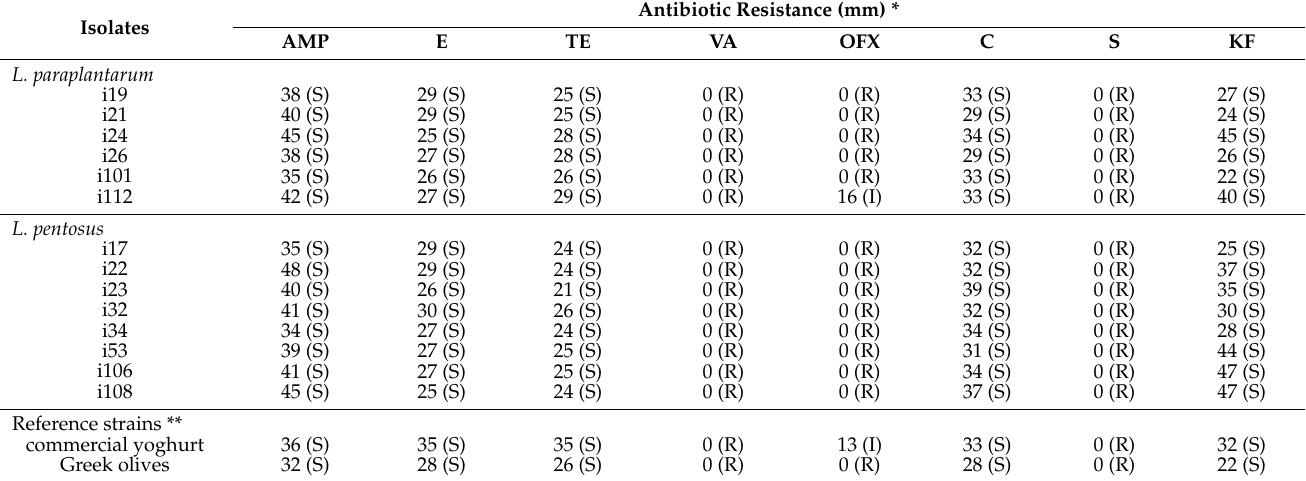
Table 4. Performance of L. pentosus and L. paraplantarum strains pertaining to antibiotic resistance.